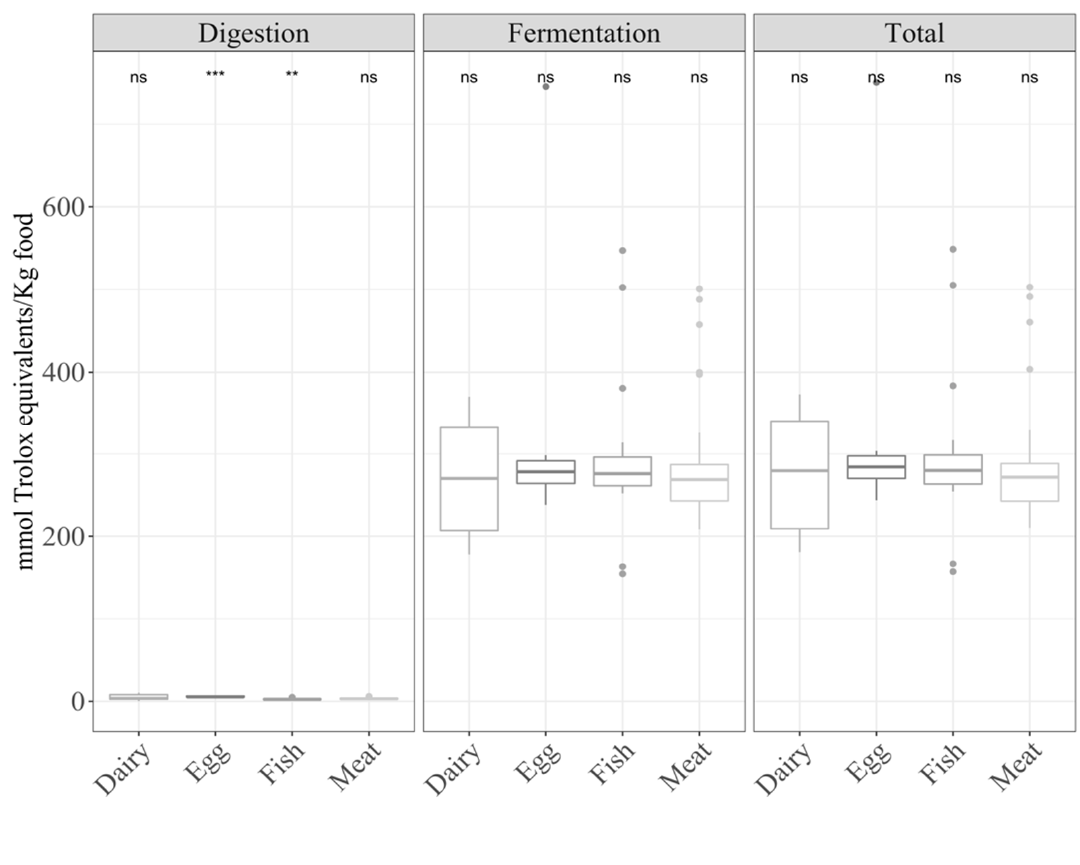
Figure 2. Antioxidant capacity of foods of animal origin (butter, cheese, milk, yogurt, egg, cod fish, salmon, beef, chicken, lamb, and pork) obtained after in vitro digestion and fermentation, depending on the food group (( A ) TEAC DPPH and ( B ) TEAC FRAP ). Statistical analysis was performed via ANOVA using the mean antioxidant capacity of all food groups as the reference group. Statistic labels: *: p < 0.05, **: p < 0.01, ***: p < 0.001, ****: p < 0.0001, ns: not